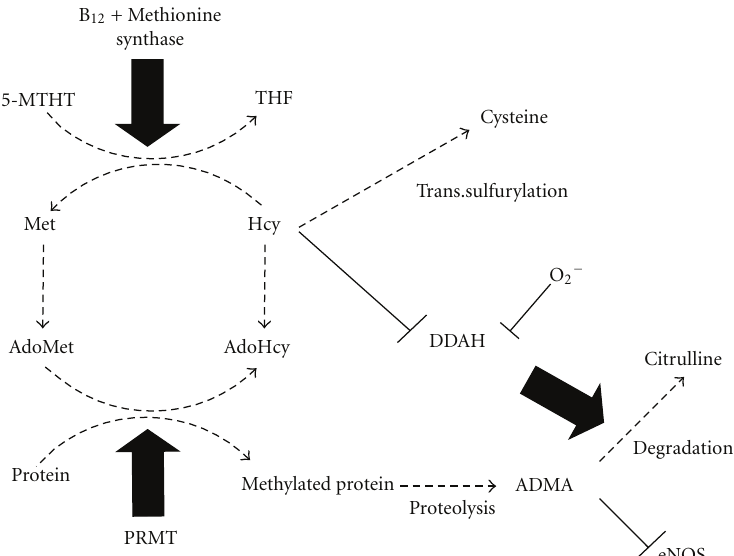
Figure 3: Intracellular synthesis and metabolism of homocysteine (Hcy) and asymmetric dimethylarginine (ADMA) and their biochemical link. Vitamin B 12 serves as a cofactor for the formation of methionine (Met) from homocysteine (Hcy) by methionine synthase using 5- methyl-tetrahydrofolate (5-MTHF), the dominant folate form in serum. S-adenosylmethionine (AdoMet) is the intermediate in this reaction and serves as the methyl donor to form S-adenosylhomocysteine (AdoHcy). Hcy is either remethylated to Met or transsulfurated to cysteine. Asymmetric dimethylarginine (ADMA) is an endogenous competitive inhibitor of endothelial nitric oxide synthase (eNOS). ADMA is formed by methylation of arginine residues in proteins with protein methyltransferase (PRMT) and released after proteolysis. Metabolism of ADMA is mediated by dimethylarginine dimethylaminohydrolases (DDAHs), which are downregulated by reactive oxygen species and